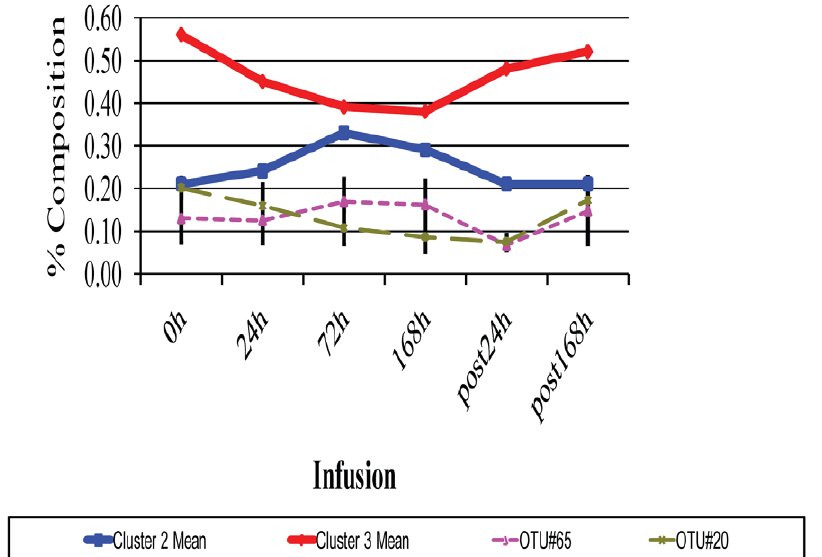
Figure 5. Temporal profiles of the relative abundance (% reads) of Operational Taxonomical Units (OTUs) of Clusters # 2 and 3. Clusters were generated based on Self Organizing Maps (SOM). Group Mean represents mean normalized percentages of OTUs of 4 samples in this cluster ( N =4). A temporal profile of representative OTUs (OTU # 65 and OTU # 20) that belonged to clusters # 2 and 3, respectively was shown as a reference. Error bars represent SD of 4